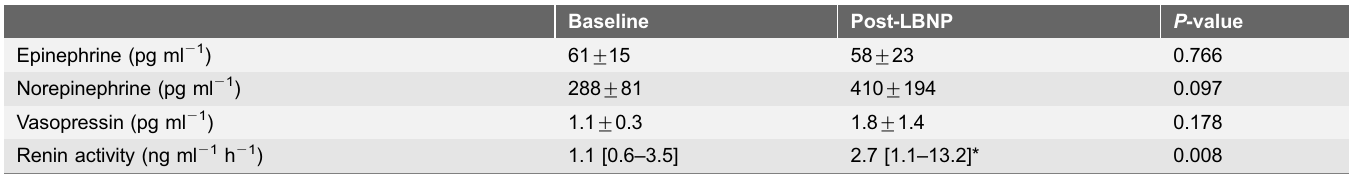
Table 5. Circulating vasoactive hormones and plasma renin activity before and 5 min after lower body negative pressure (post-LBNP) was ceased because of presyncopal